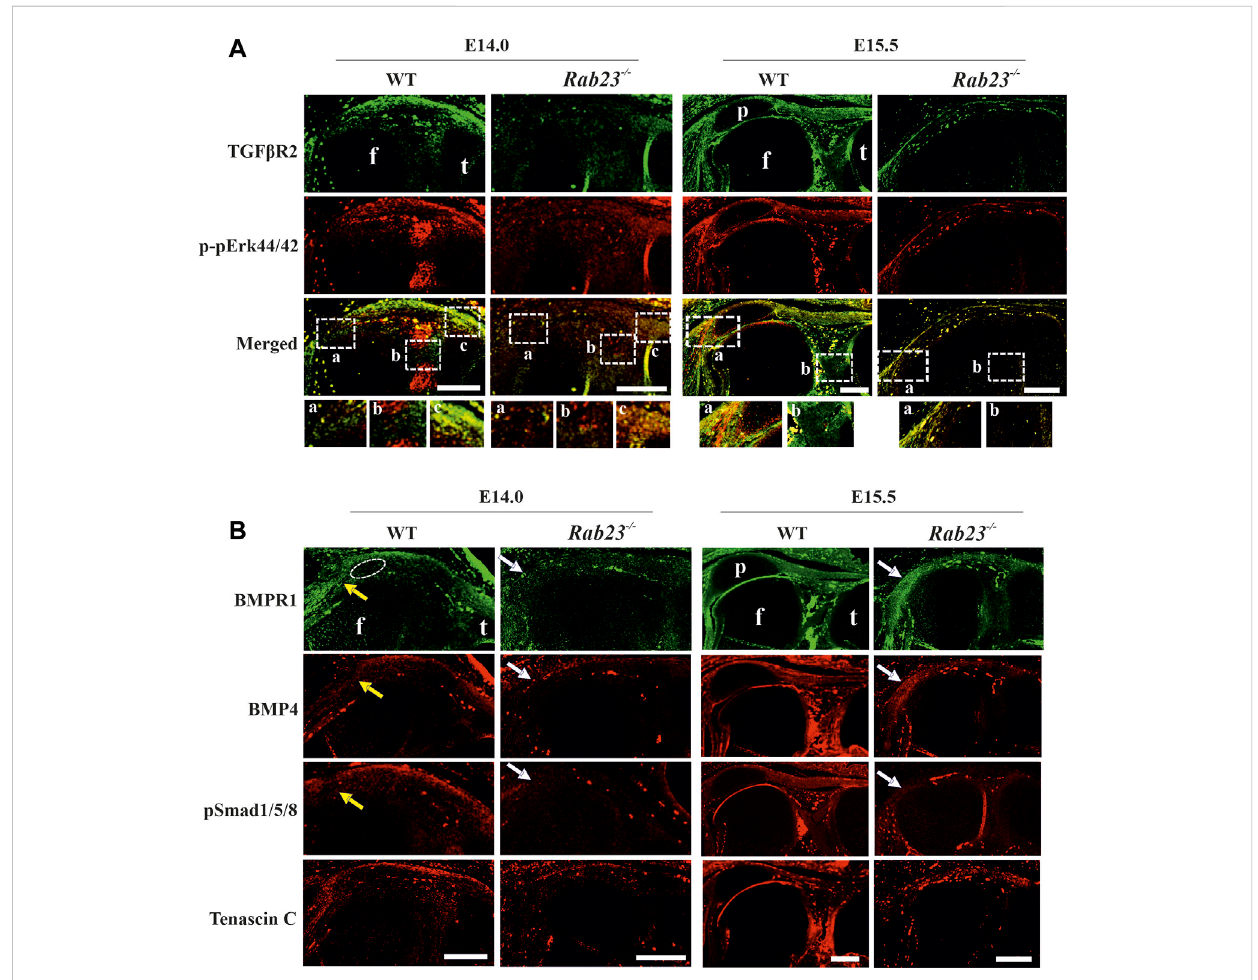
FIGURE 5 Analysis of TGF β R2, phospho-pErk44/42, and BMP signaling during patella, tendonogenesis, and ligamentogenesis. (A) Immunohistochemical expression analysis of TGF β R2 and phospho-pErk44/42 in sagittal sections of the hind limbs obtained from E14.0 and E15.5 Wt and Rab23 − / − embryos. In Wtsamples,TGF β R2isexpressedinthepatellasite,patellatendon,quadricepstendon,rectusfemoris,andvastusmedialistendonandalsointhecruciate ligaments in Wt samples. In Rab23 − / − samples, TGF β R2 expression remained rudimentary and aberrant at both the embryonic stages analyzed. The Wt sample at E14.0 shows the expression of phospho-pErk44/42 in the patellofemoral junction except for the cruciate ligament. At E15.5, phospho- pErk44/42showsexpressionintheboundarycellsofthepatellofemoralstructureandalsobeneaththequadricepstendon.Thisexpressionwasalteredin Rab23 − / − samples ( n = 3 samples for each age and genotype). p: patella, f: femur, and t: tibia. Scale bar: 200 μ m. (B) Immunohistochemical expression analysis of BMP signaling components BMP4, BMPR1, and pSMAD 1/5/8 in sagittal sections of the hind limbs obtained from E14.0 and E15.5 Wt and Rab23 − / − embryos. BMPR1, BMP4, and pSMAD 1/5/8 expression images show that all these markers are expressed in the patella site, patella tendon, quadricepstendon,rectusfemoris,andvastusmedialistendon(yellowarrow)inE14.0andE15.5samples.In Rab23 − / − samples,BMPR1,BMP4,andpSMAD 1/5/8 expressions are barely detectable in these structures at E14.0 (white arrow) and show expression mostly in the femur head toward the rectus femoris and vastus medialis tendon (white arrow) at E15.5. To highlight the structural protein in the tendon and ligament cells, sagittal sections from E14.0 and E15.5 hind limbs were stained with Tenascin-C (lower panel). Dotted circle indicates the future patella site. ( n = 3 samples for each age and genotype). p: patella, f: femur, and t: tibia. Scale bar: 200 μ